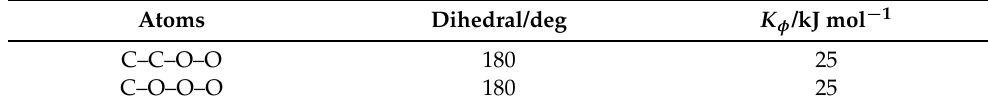
Table 4. Dihedral angle parameters for the CG models of CB7CB.